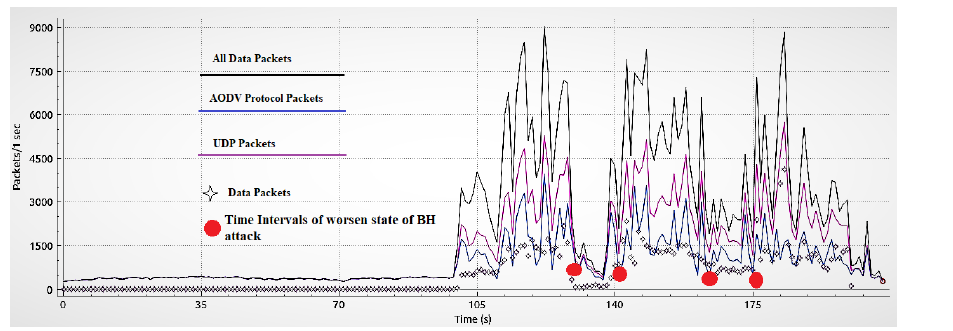
Figure 10. Protocol Hierarchy of all protocols’ packets .